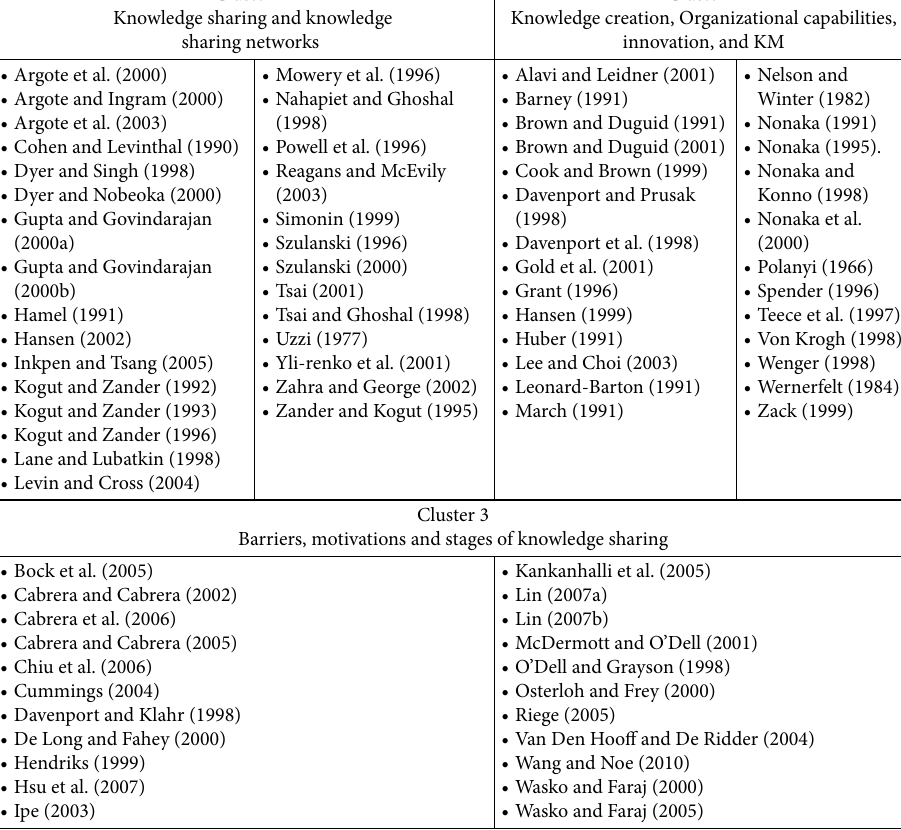
Table 7. Clustering resulting for the most cited